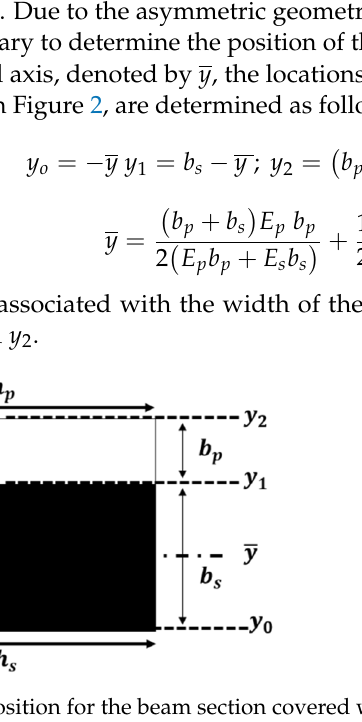
Figure 2. Neutral axis position for the beam section covered with the piezoelectric material.